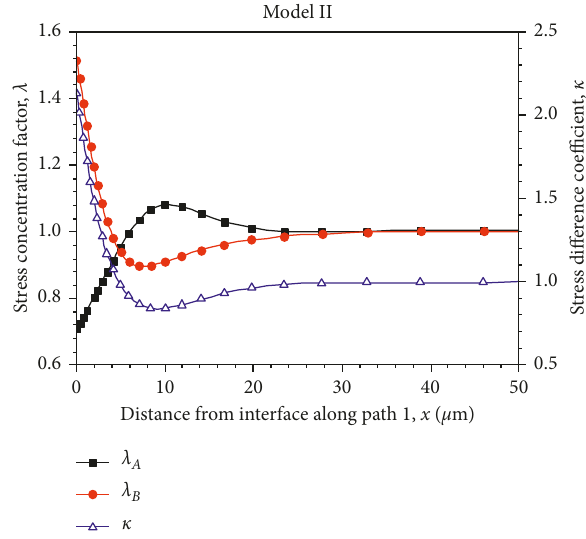
Figure 10: Mises stress concentration factor and Mises stress difference coefficient of model II along path